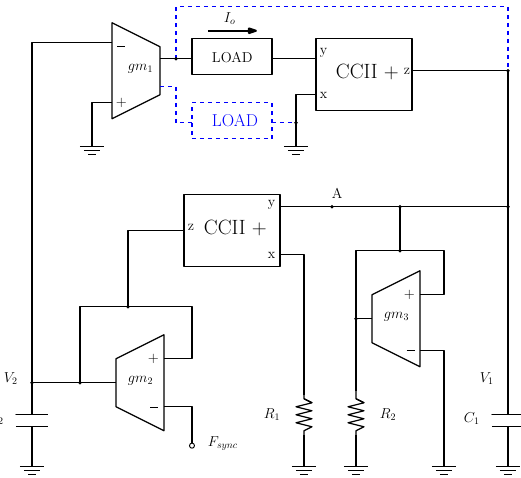
Figure 3. Proposed current oscillator. The current conveyors CCII + are OPA860 and transconductors are